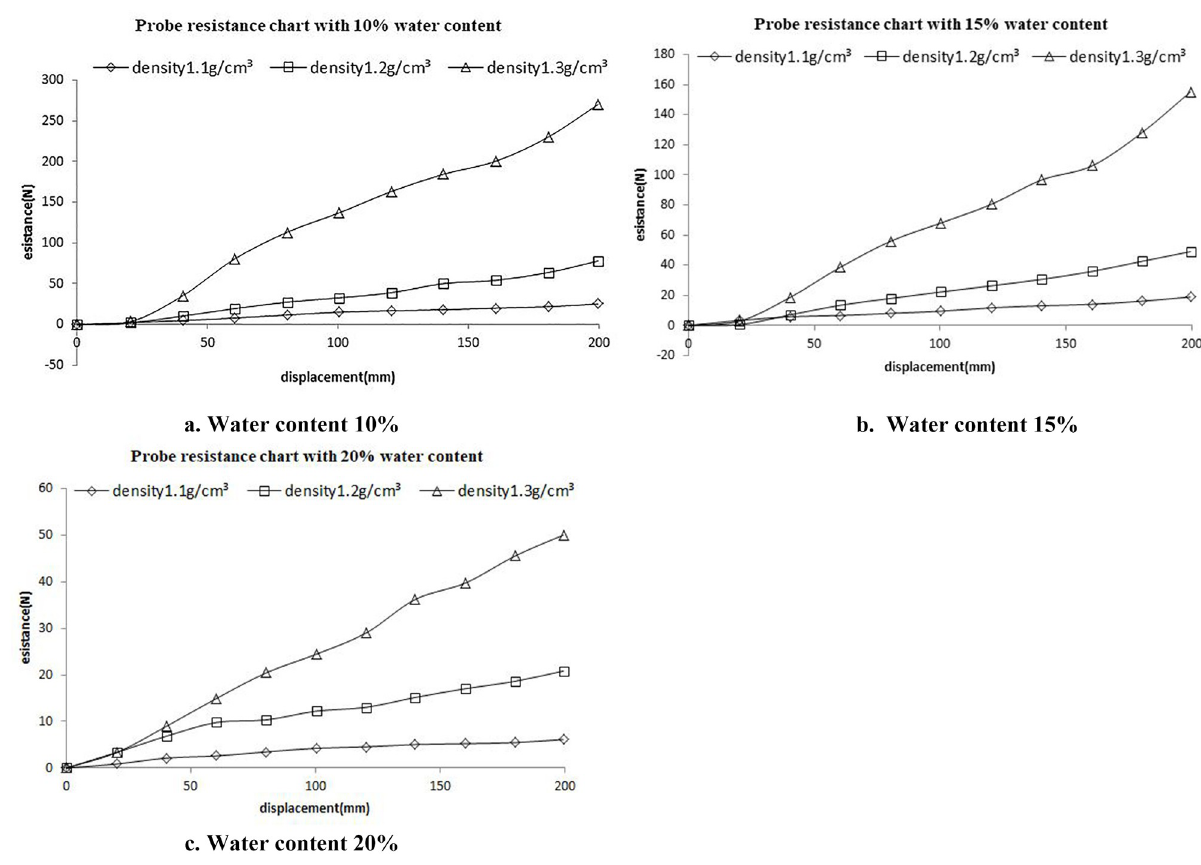
Fig 4. Probe penetration resistance